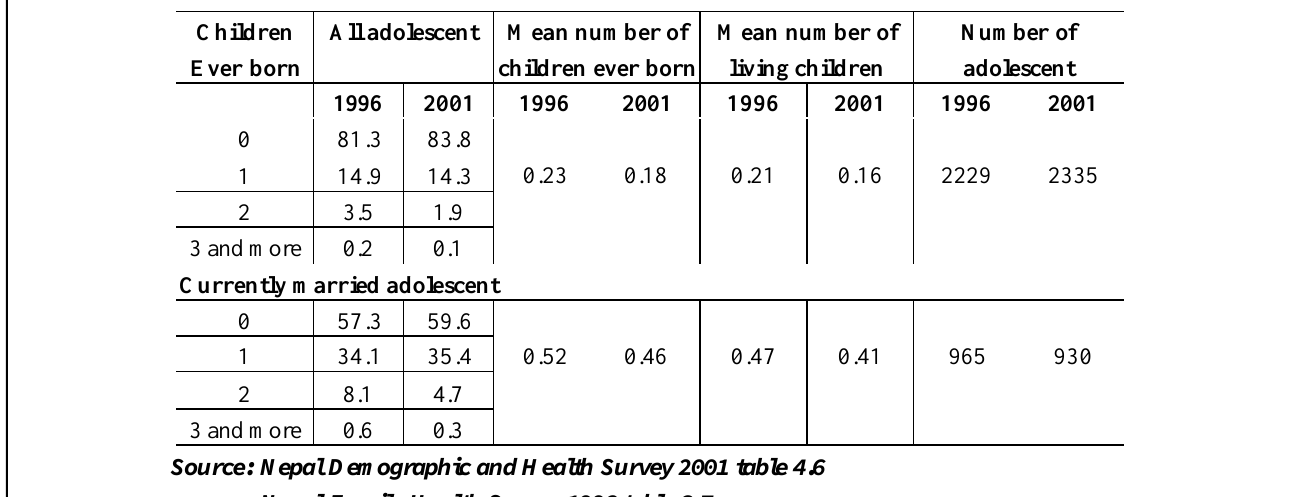
Table IV : Percentage distribution of adolescent aged 10-19 years by children ever born